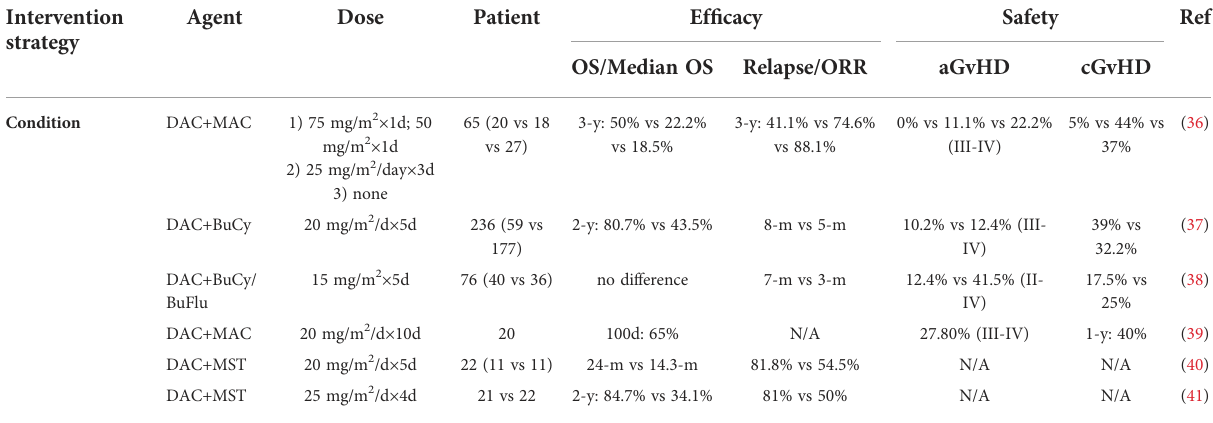
TABLE 2 The use of hypomethylating agents during hematopoietic stem cell transplantation in MDS or AML.